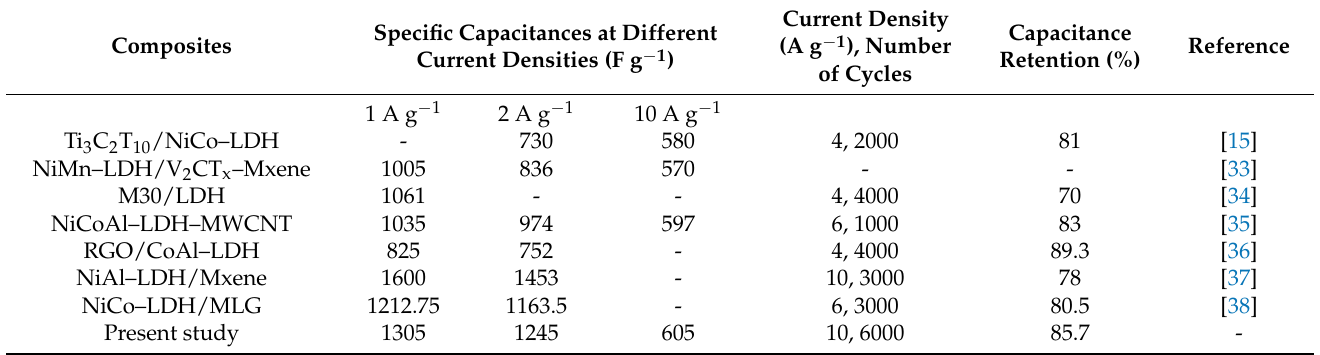
Table 1. Comparison of the electrochemical performance of NiCoFe–LDH/V 2 CT x –MXene with LDH-based composites containing other conductive substrates.